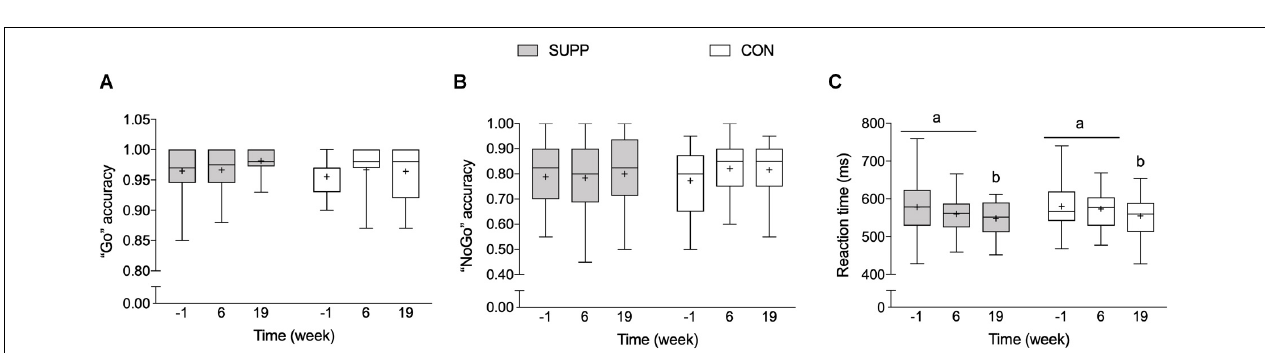
FIGURE 5 | Working memory inhibition control (a measure of executive functions), assessed with the Go-NoGo Task. (A) Accuracy (i.e., percentage of correct responses) during “Go” trials. (B) Accuracy during “NoGo” trials. (C) Reaction time during correct “Go” trials. Boxes (SUPP: gray; CON: white) represent interquartile (25th to 75th percentile) ranges, with the horizontal lines indicating the median. Whiskers represent the maximal and minimal values, and the cross indicates the mean. Dissimilar letters denote changes over time within a given treatment group (SUPP or CON). SUPP, supplement; CON, control.